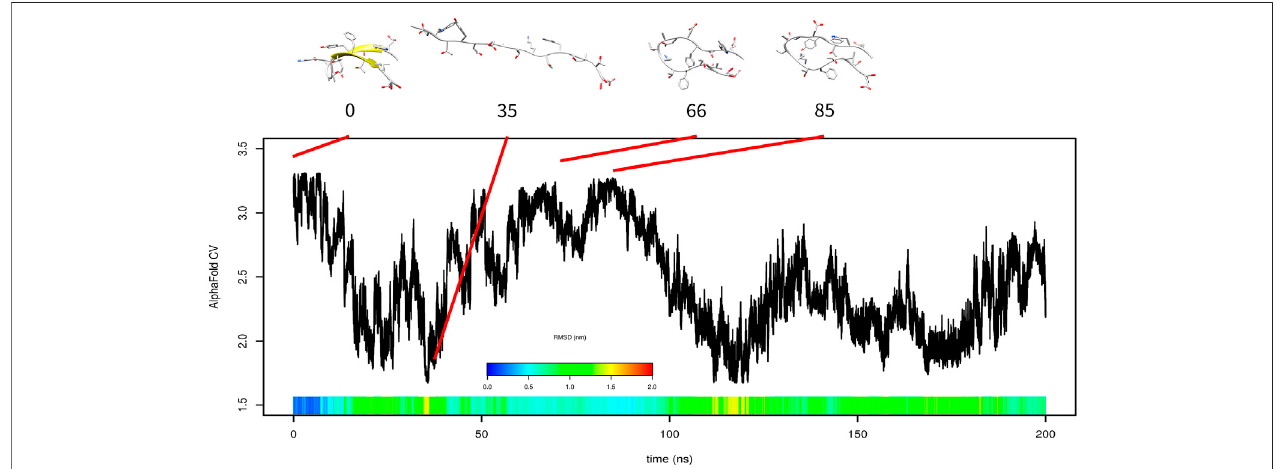
FIGURE 8 | Results of metadynamics simulation of β -hairpin with the AlphaFold collective variable with selected structures. RMSD is depicted in the color scale.